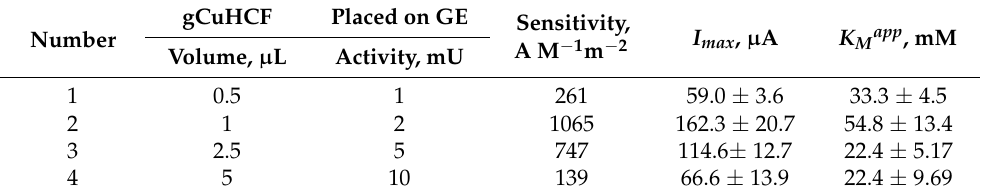
Table 3. Effect of gCuHCF PO-mimetic activity on the analytical characteristics of the modified GEs at pH